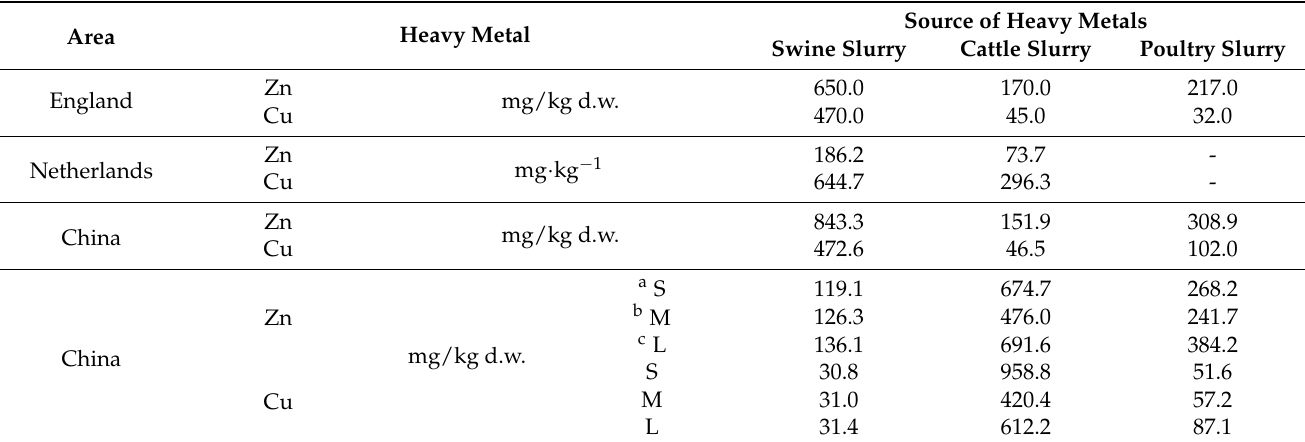
Table 2. Concentration of Zn and Cu in livestock manures [27–30].